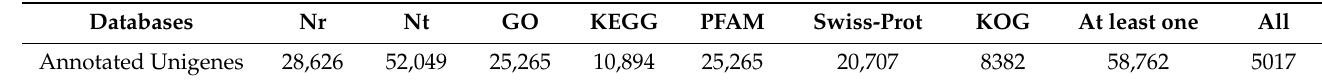
Table 2. Summary of the annotation